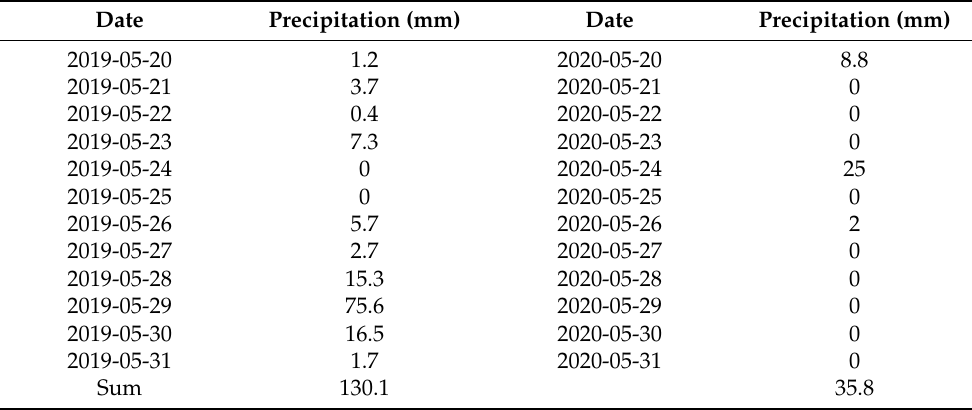
Table 10. Precipitation in the head spraying period in the last decade of May 2019 and 2020 for Ljubljana,